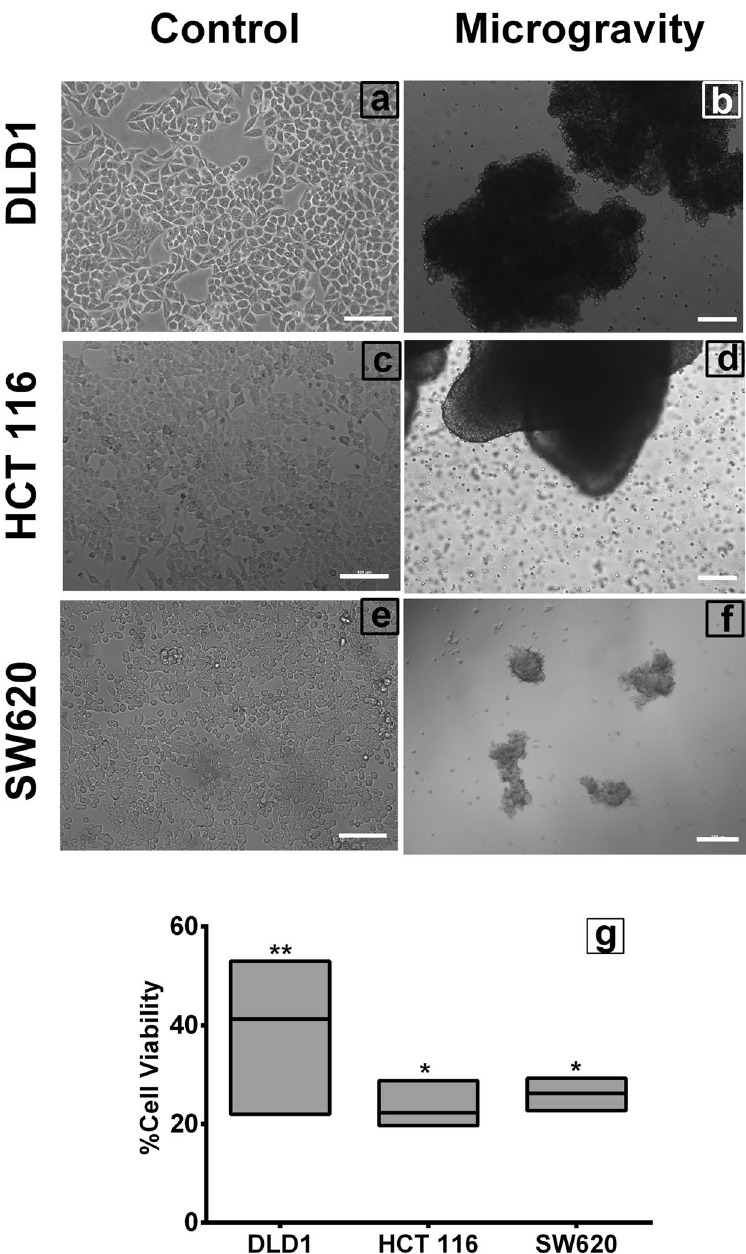
Figure 1. Simulation of microgravity induces cell clumping. The colorectal cancer cells DLD1 ( a ), HCT116 ( c ) and SW620 ( e ), when cultured in Rotary cell culture system at 10 RPM for 48 hours to simulate microgravity clump together to form large 3D structures ( b , d , f ) DLD1, HCT116 and SW620 respectively. Scale bar represents 200 μ m. XTT assay of the microgravity simulated cells ( g ) shows the cell viability was significantly reduced. The experiment was performed thrice with individual controls ** P < 0.005, * P < 0.05. Data represented as mean +